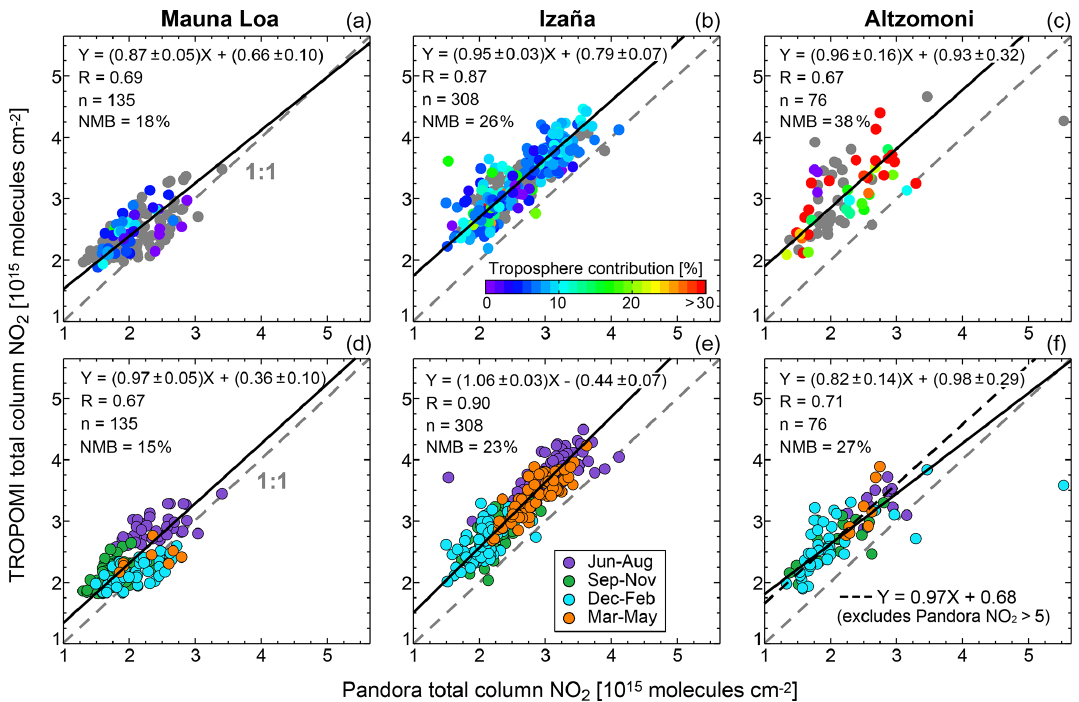
Figure 3. Comparison of TROPOMI and Pandora total NO 2 columns at high-altitude sites located in the free troposphere ( > 2km altitude). Points are daily means with at least five coincident observations at Mauna Loa (a, d) , Izaña (b, e) , and Altzomoni (c, f) before (a, b, c) and after (d, e, f) applying correction factors to TROPOMI stratospheric and tropospheric columns (see text for details). Colours in (a, b, c) are the relative contribution of the free troposphere to the total column according to Pandora where available and grey otherwise. Data in (d, e, f) row are coloured by season. Lines are the 1 : 1 relationship (grey dashed) and RMA regression (black solid). Inset values are Pearson’s correlation coefficients, RMA regression statistics, number of data points ( n ), and the TROPOMI normalized mean bias (NMB). Also shown for Altzomoni (f) is the RMA regression without the Pandora > 5 × 10 15 molec.cm − 2 observation (black dashed line). Axes do not start at the